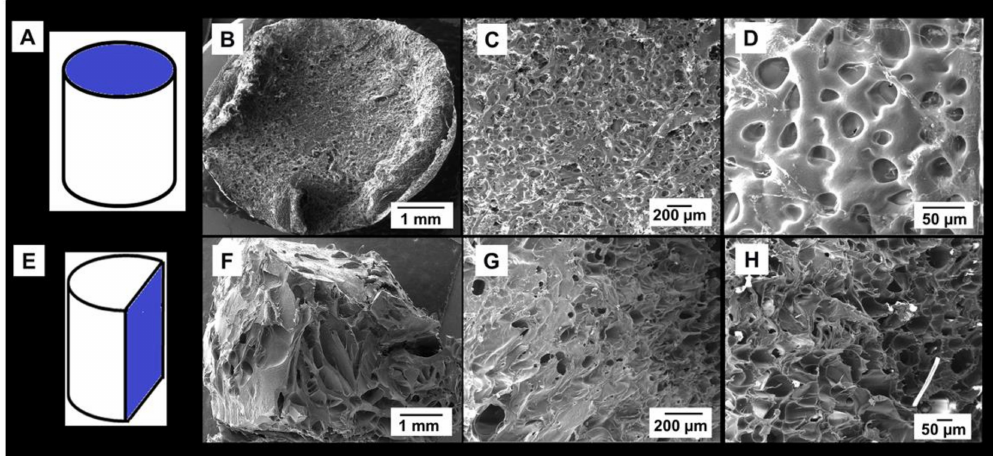
Figure 3. Representative secondary electron—SEM images of the microstructure of lyophilized PVP hydrogel: ( A – D ) top surface and ( E – H ) longitudinal